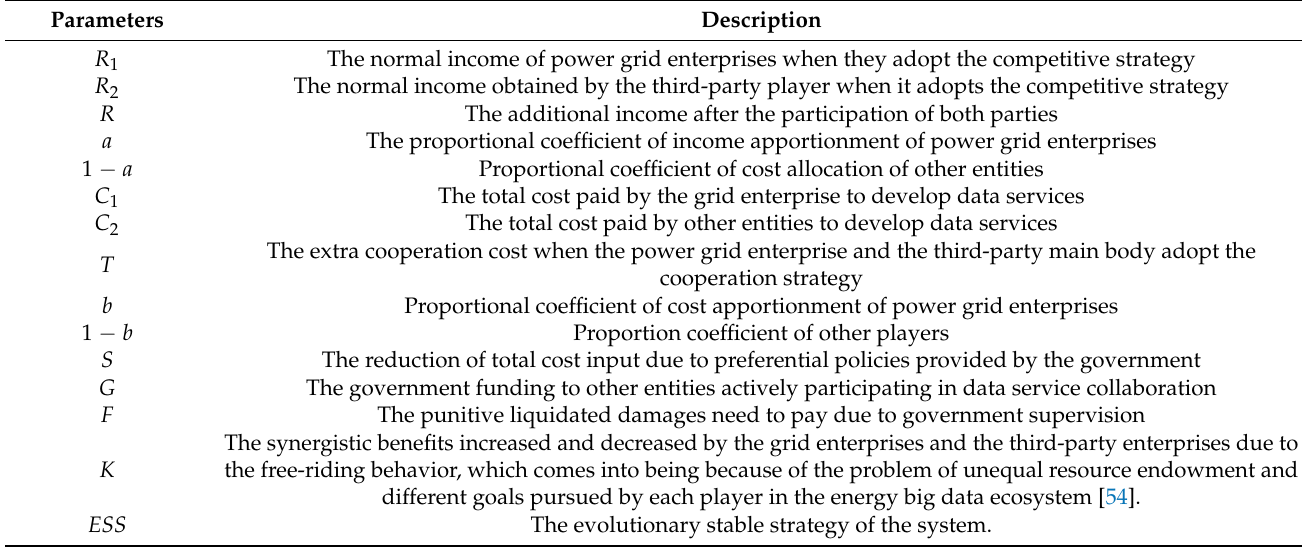
Table 2. Assumptions about the system